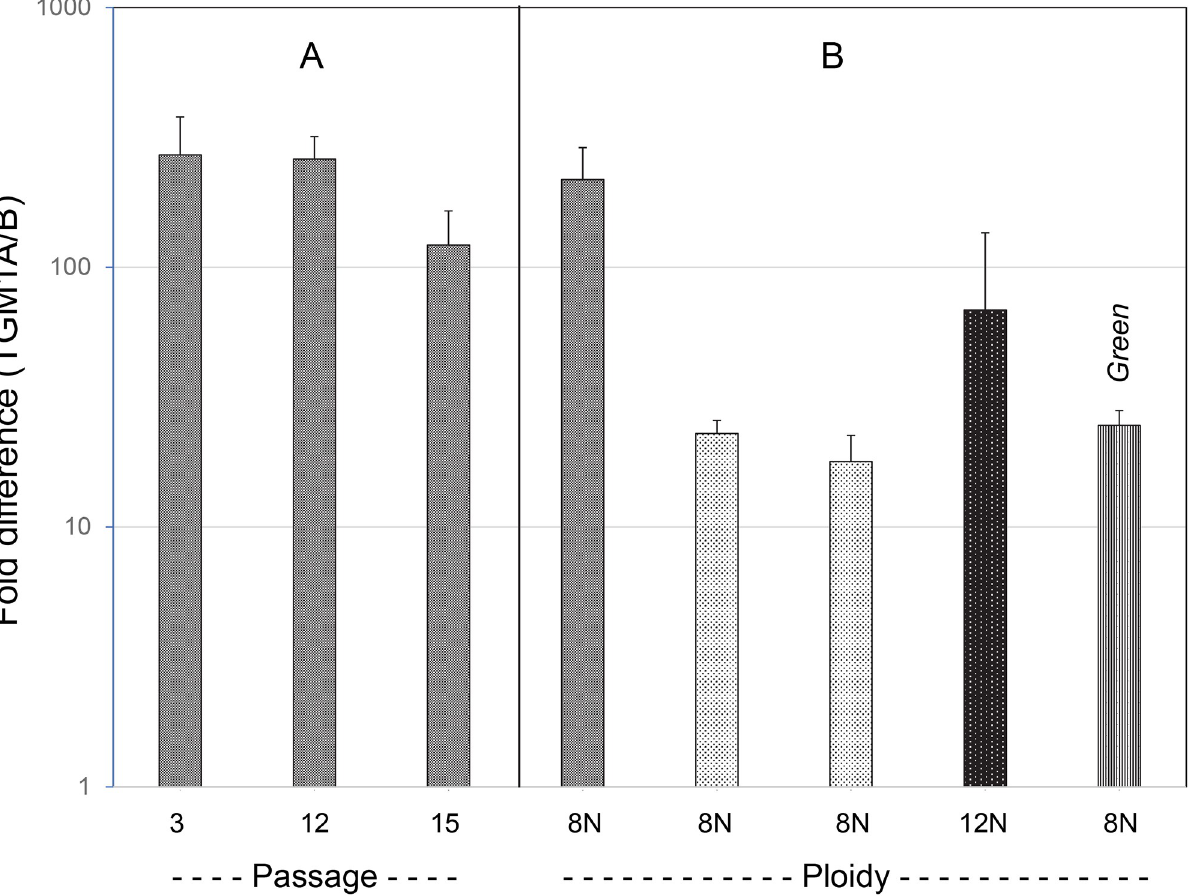
Fig 3. Relative expression levels of TGM1 A and B determined by real time PCR. (A) RNA was isolated from the indicated passages of cells from a single sturgeon. (B) The average ratio TGM1A/TGM1B in panel A is shown along with the ratios for two other octoploid (8N) white sturgeon (lighter shading), a dodecaploid white sturgeon (12N, dark shading) and a green sturgeon (as labeled). Error bars indicate values derived from 2 or 3 independent cultures except for P3 (7